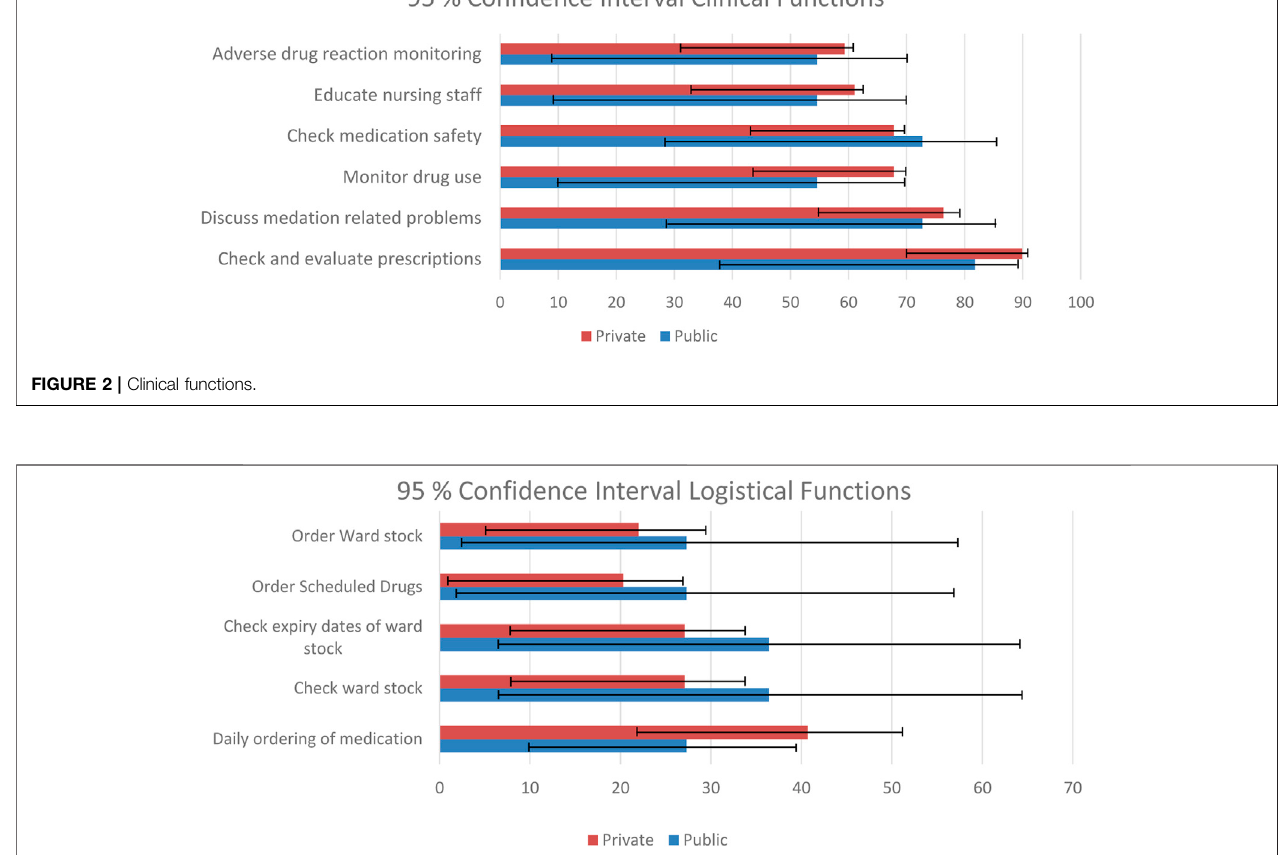
FIGURE 3 | Logistical